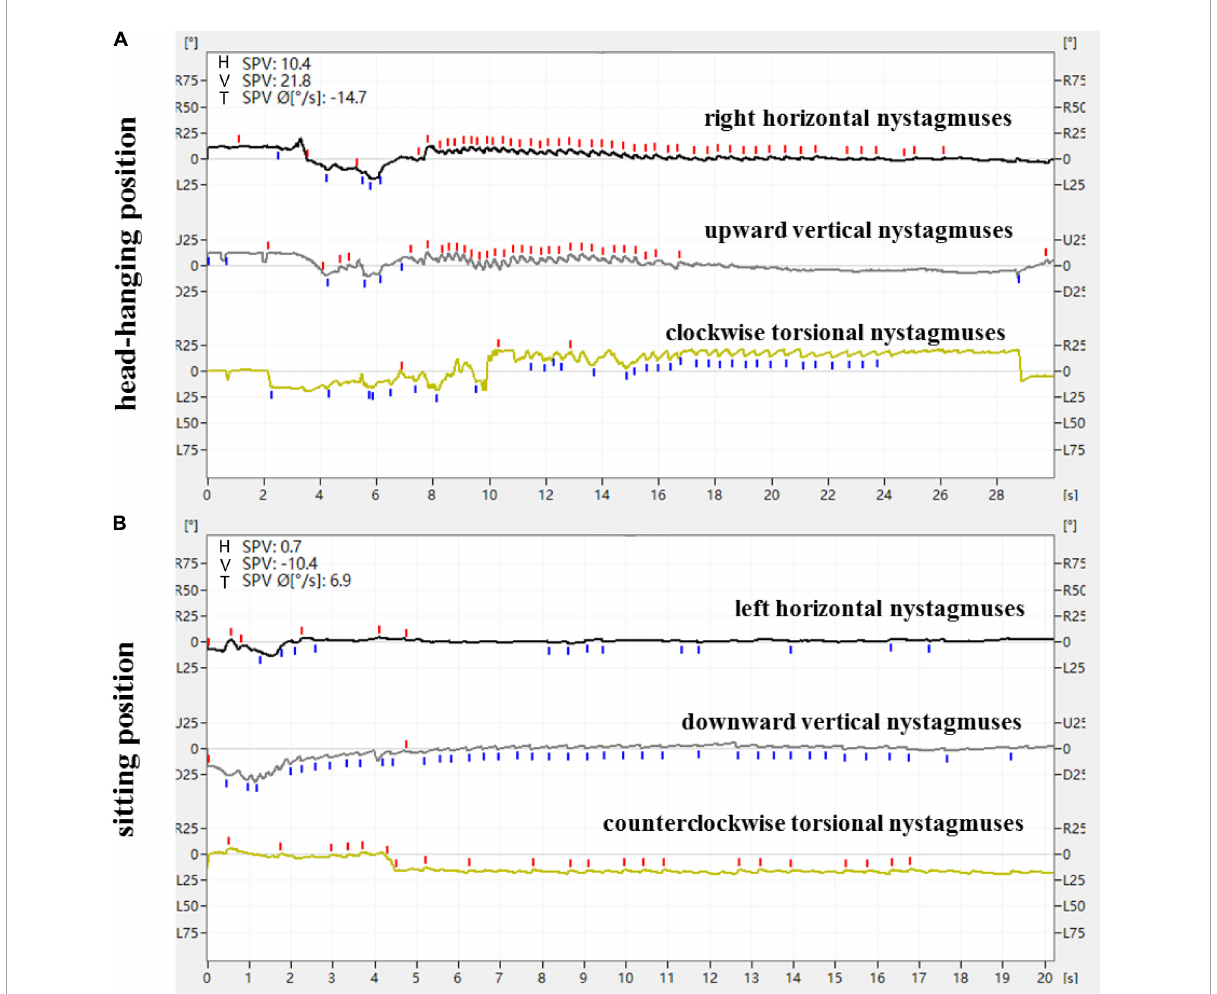
FIGURE1 Expression of nystagmus on the 3D-VNG by Dix-Hallpike test of a patient with L-PSC-can. (A) At the head-hanging position, the right horizontal nystagmuses were recorded as upward fast-phase nystagmus curves, the upward vertical nystagmuses were recorded as upward fast-phase nystagmus curves, and the clockwise torsional nystagmuses were recorded as downward fast-phase nystagmus curves. (B) The direction of nystagmus was reversed when the head was recovered from the head-hanging position to the sitting position.